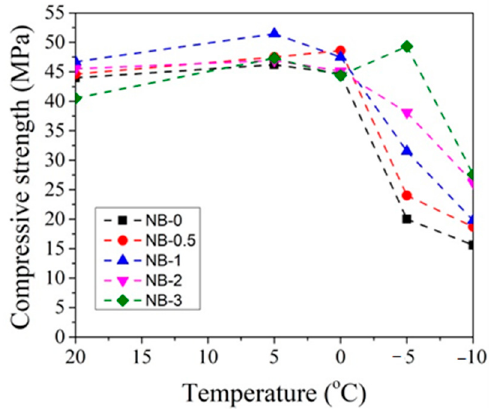
Figure 20. Compressive strength of concrete with CEM IIR after 28 days as a function of initial curing temperatures (°C) for CN dosages in the range from 0% to 3%.